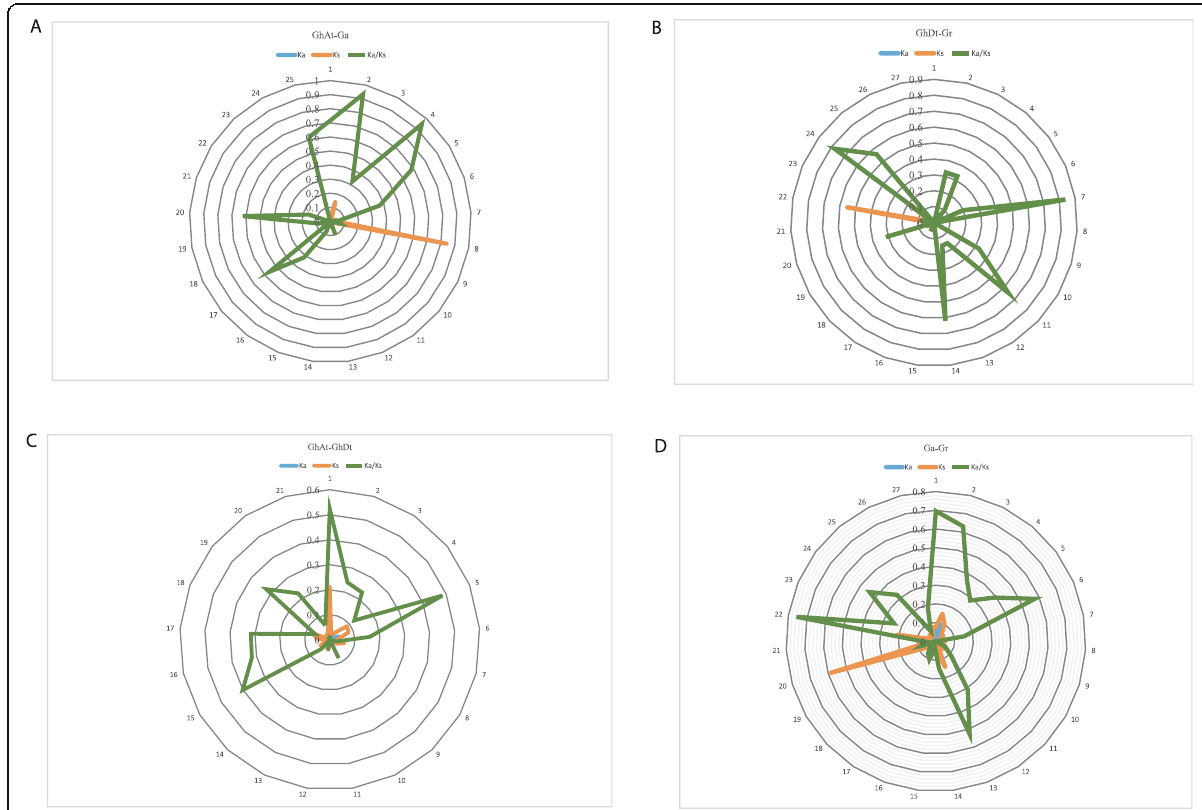
Fig. 7 Gene evolution forms of Ka, Ks and Ka/Ks values for homologous LHC gene pairs a G. hirsutum At – G. arboreum b G. hirsutum Dt - G. raimondii c G. hirsutum At – G. hirsutum Dt d G. arboreum – G.